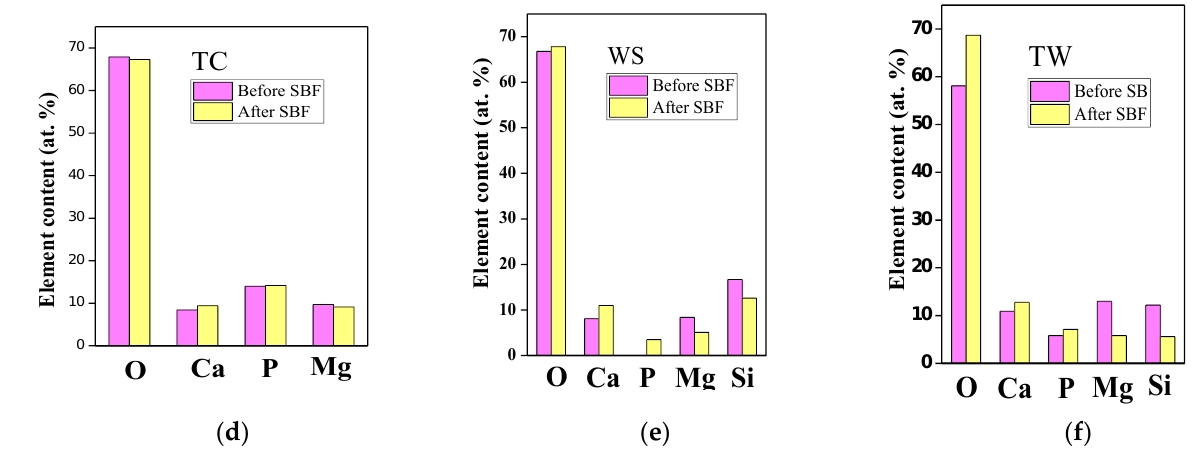
Figure 15. SEM images of the coatings after the SBF ( a – c ), the elemental composition of the coatings before and after the SBF ( d – f ).